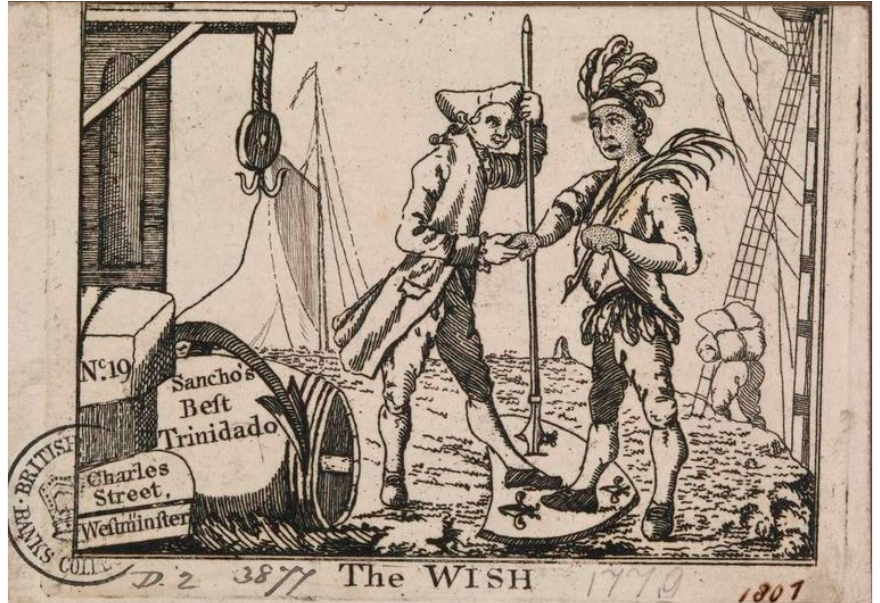
Figure 3. “ The Wish”, tobacco-paper for (Ignatius) Sancho’s Best Trinidado, at No. 19 Charles Street, Westminster, c. 1774–80, D,2.3877, etching (D,2.3877). © The Trustees of the British Museum. Other cards created a sociable fraternity between black and white males. Catherine